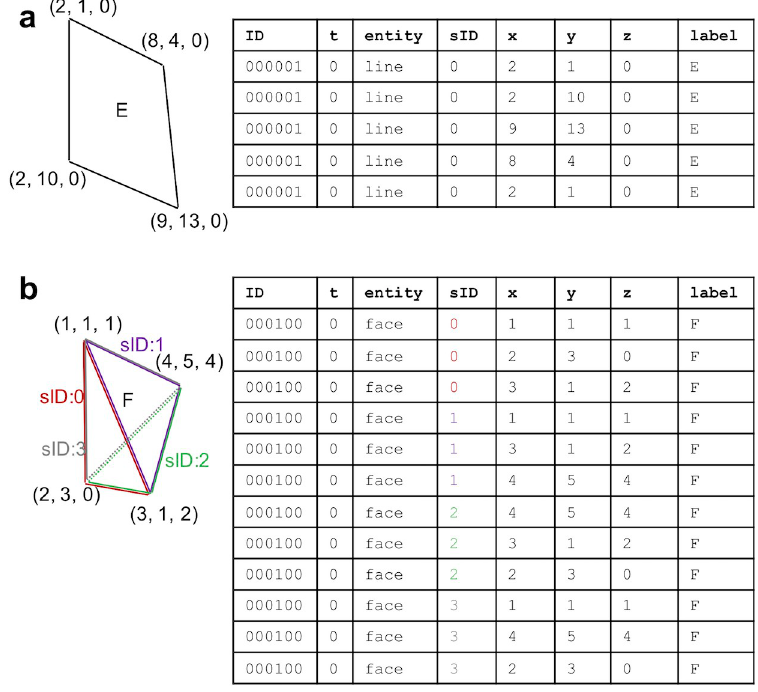
Fig 3. An example of the description of the spatiotemporal information of 2D quadrilateral-shaped and 3D trigonal pyramidal objects by using line (a) and face entities (b), respectively. The sequential identifier (sID) represents a set of coordinates that can be connected from the top to describe an entity within one biological object.